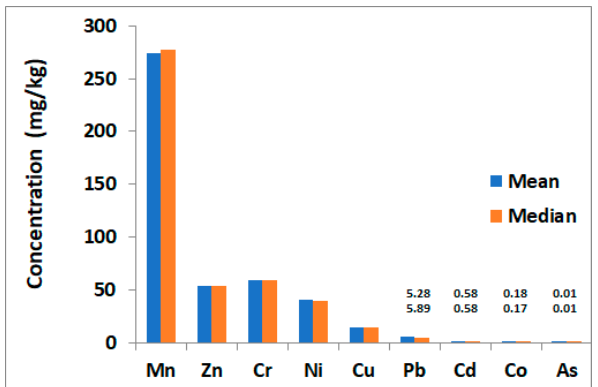
Figure 3. Mean and median concentrations (mg/kg) of heavy metals in the soil samples collected from Liwa, Abu Dhabi.